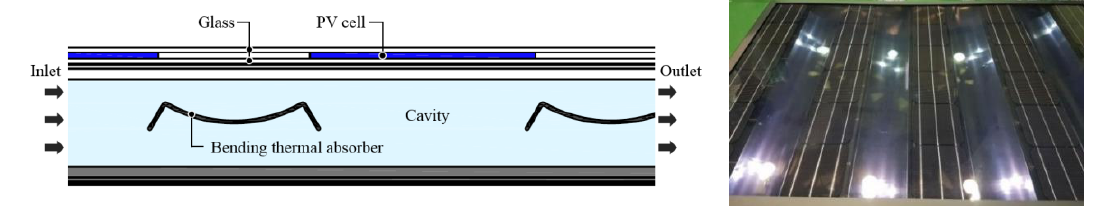
Figure 5. Applied air-type BIPVT collector.